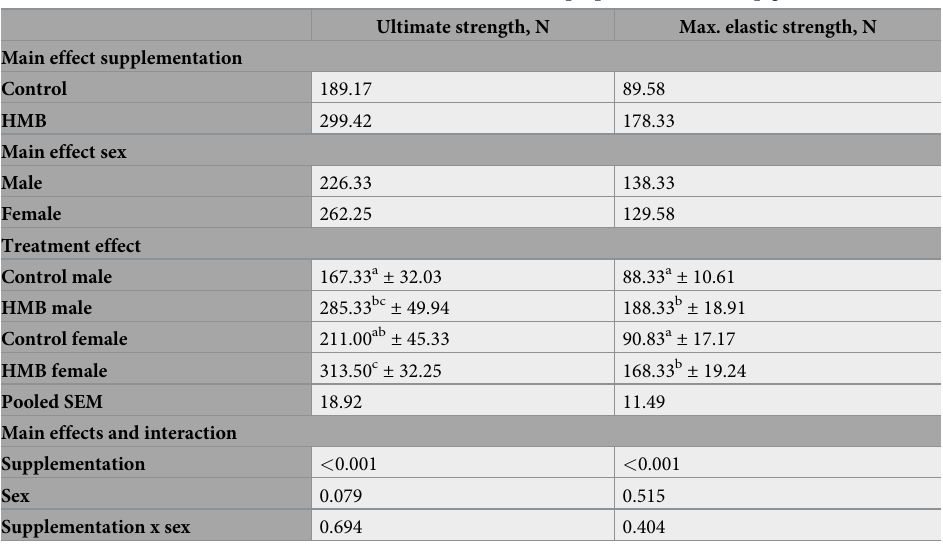
Table 2. The effect of maternal treatment with HMB on mechanical properties in newborn piglets.